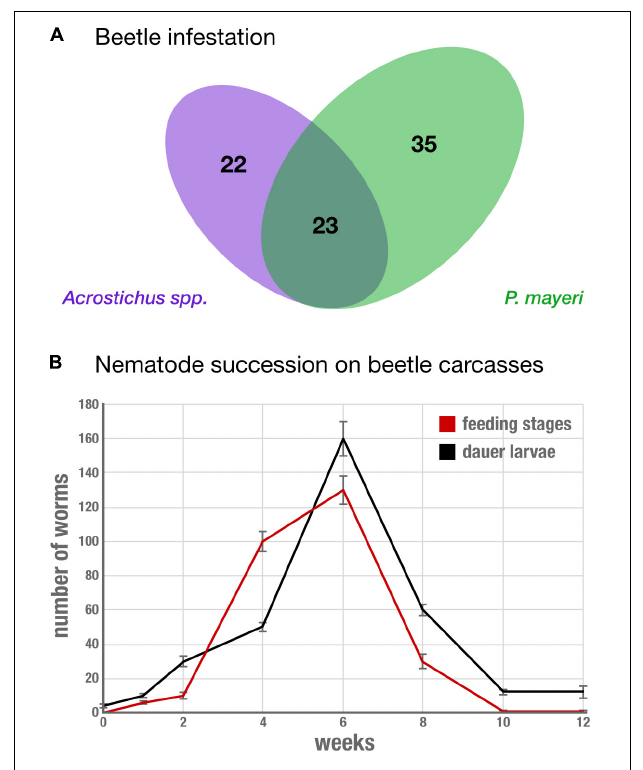
FIGURE 2 | Reliably co-infested G. bupthalma remains home to various stages of both P. mayeri and Acrostichus . (A) 80 adult G. bupthalma were investigated across 3 months. A total of 22 individuals harbored only Acrostichus spp. and 35 only P. mayeri . 23 individuals were infested with both Acrostichus and P. mayeri . (B) Nematode succession on the carcass over 3 months. The populations of both dauers (black) and feeding mixed stages (red) increase during the first 6 weeks, reaching a peak at 6 weeks (160 dauers and 130 feeding stages), and then decrease until the population is almost depleted at 12 weeks (12 dauers and 1 feeding stage). N = 8 beetles per time point, average number shown. Error bars are standard error of the